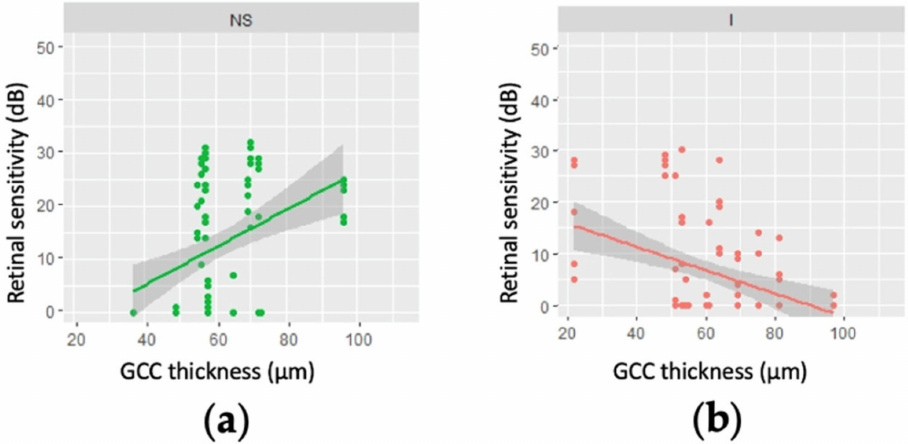
Figure 5. Linear regression modelling of retinal sensitivity as a function of ganglion cell complex (GCC) thickness for regions of the 10-2 visual field for 15 patients (15 eyes) with a mean deviation worse than − 20 dB. ( a ) the nasal superior region—the regression slopes ranged from 0.40 to 0.49 ( p = 0.15); ( b ) the inferior region—the regression slopes ranged from − 0.31 to − 1.08 ( p = 0.17).